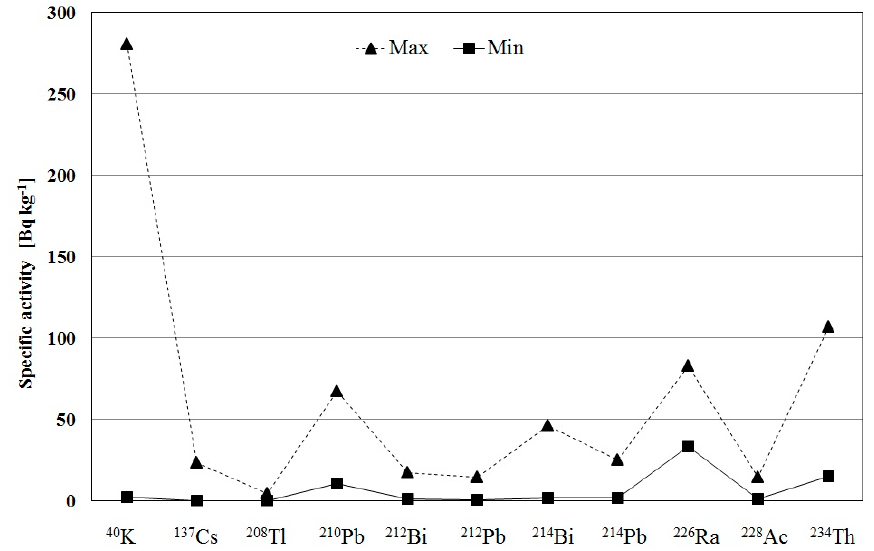
Figure 2. Extreme values of specific activity of radionuclides measured in the collected data.